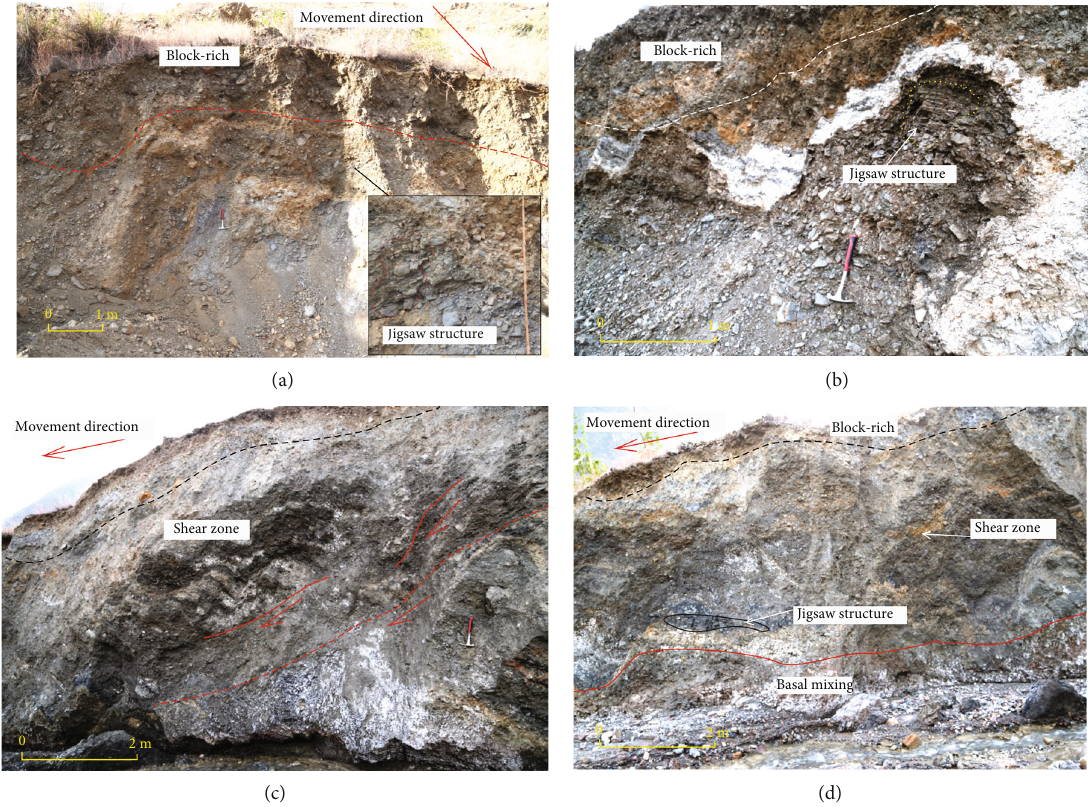
Figure 6: Internal structural features of sediments taken from distal deposits of Luchedu rockfall. (a) The puzzle structure of broken and sheared materials on the surface about 4.8 km away from the source. (b) Lique fi ed soil interlayer. (c) Multishear band deformation. (d) Purplish red clastic mixed zone at the